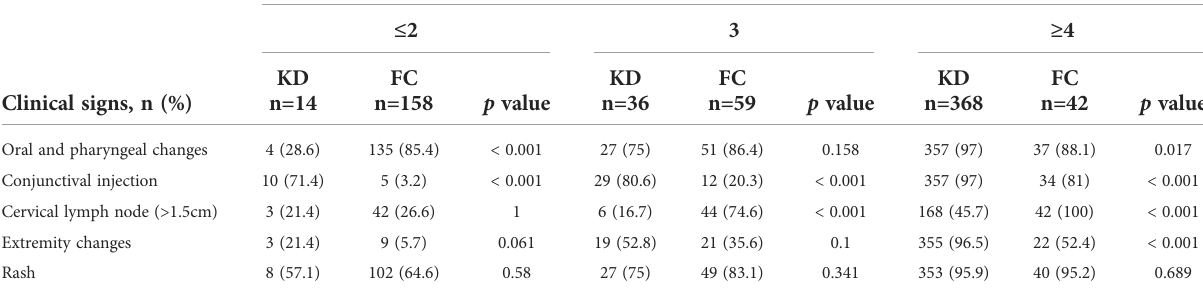
KD principal clinical